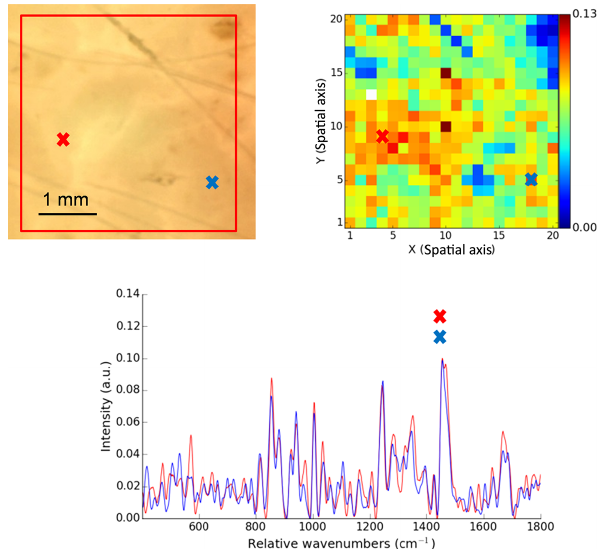
Fig. 7: Granules and powder of the pain reliever Aspirin Effect. Upper left: Camera picture. Upper right: Pseudo color Raman image of the intensity at 1606 cm -1 , which corresponds to the distribution of the agent acetylsalicylic acid. Below: Corresponding SERDS spectra at the positions and (1 s recording time per laser).